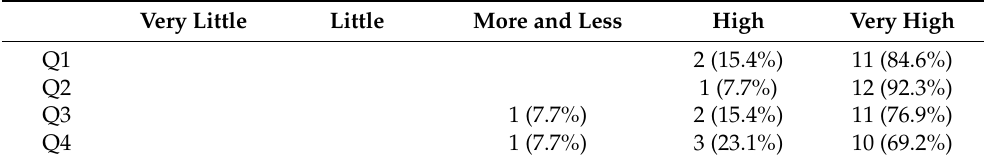
Table 5. Frequency of the answers to the questions with a five-point Likert